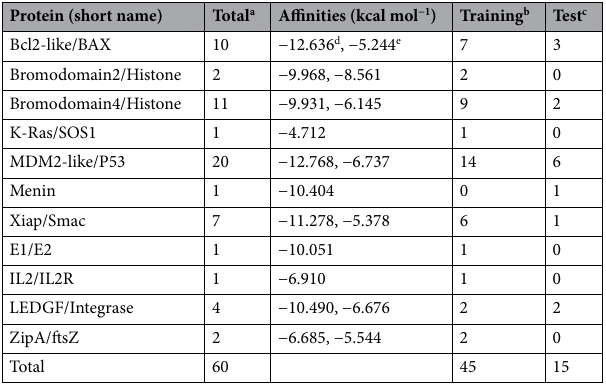
Table 1. The iPPIs dataset. a Total number of protein–ligand complexes in the dataset. b Number of complexes in the training set. c Number of complexes in the random test set. d Binding affinity of the strongest protein– ligand interactions. e Binding affinity of the weakest protein–ligand